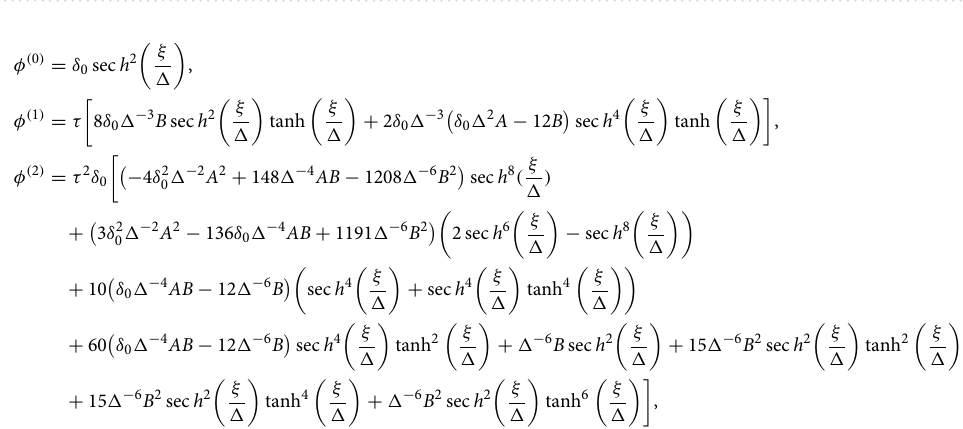
Figure 2. Phase speed ( ¯ U ph = U ph / U ph 0 with U ph 0 hot electron temperature values as T h curve), ( b ) cold electron temperature values as T c 1.02 10 3 K (dotted curve), ( c ) U ( 0 ) values as U ( 0 ) × 10 5 cm s − 1 (dotted curve) and ( d ) and 1.6 × and 0.619 (dotted